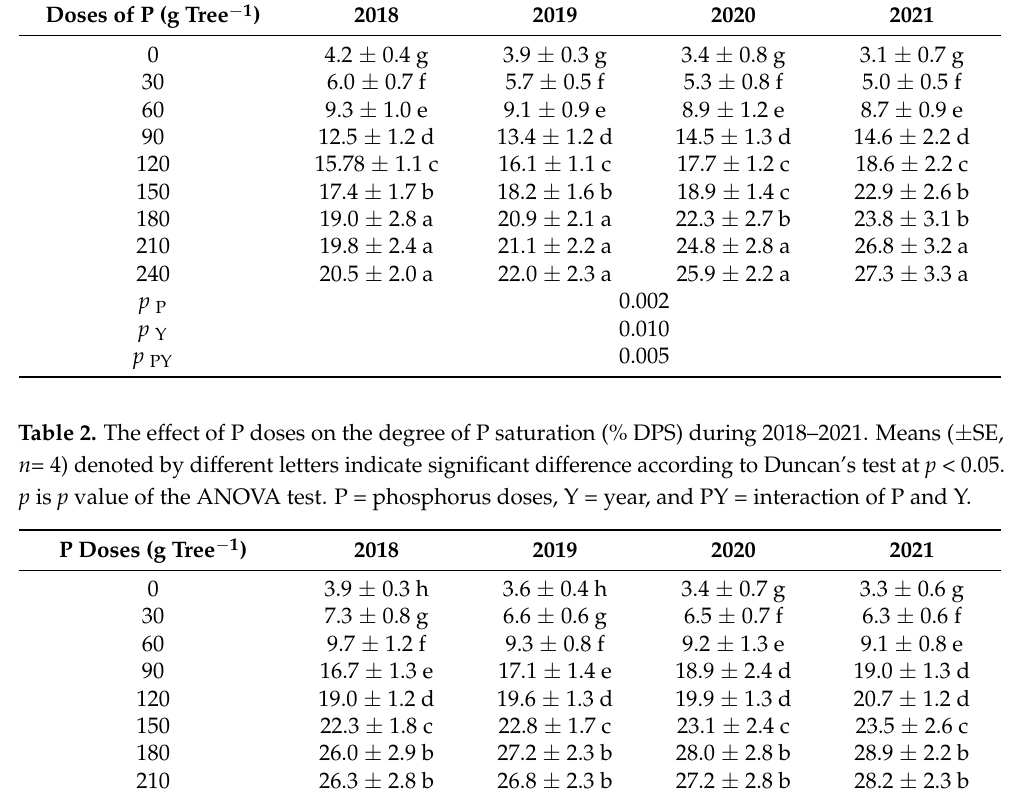
Table 1. The effect of P doses on available P during the four years (2018–2021). Means ( ± SE, n = 4) denoted by different letters indicate significant difference according to Duncan’s test at p < 0.05. p is p value of the ANOVA test. P = phosphorus doses, Y = year, and PY = interaction of P and Y. Doses of P (g Tree − 1 )